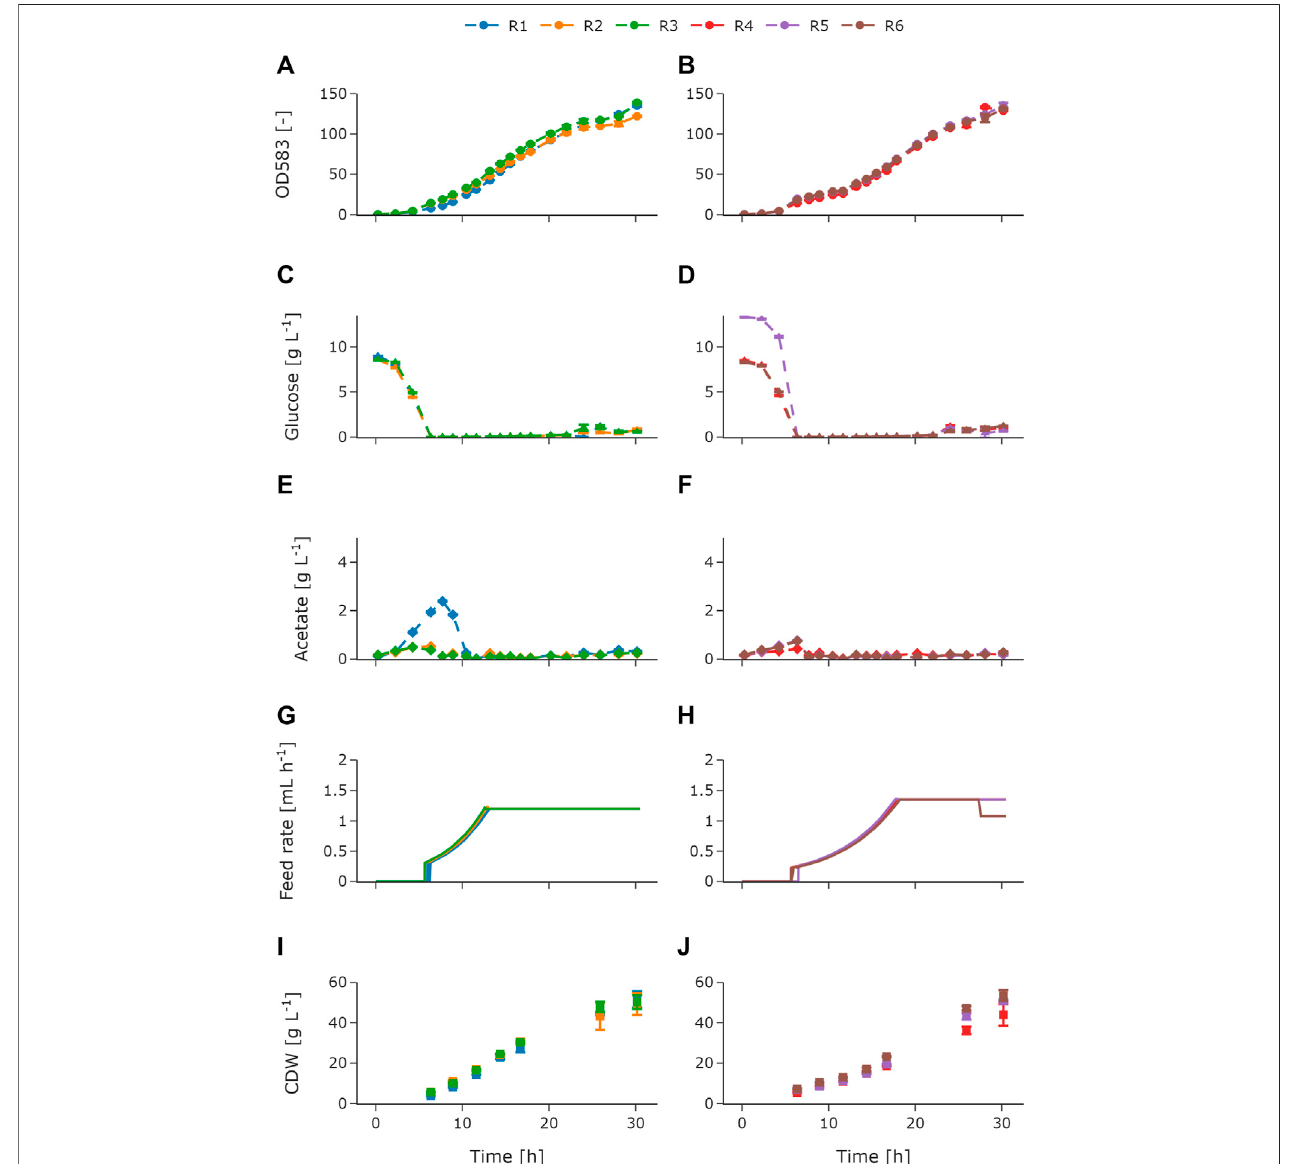
FIGURE 4 | Measured atline and of fl ine values of E. coli BW25113 fed-batch cultivations with two different feeding pro fi les as biological triplicates. OD 583 for R1 – R3 (A) and OD 583 for R4 – R6 (B) , glucose for R1 – R3 (C) and glucose for R4 – R6 (D) , acetate for R1 – R3 (E) and acetate for R4 – R6 (F) , feed rate for R1 – R3 (G) and feed rate for R4 – R6 (H) , and CDW for R1 – R3 (I) and CDW for R4 – R6 (J) . For R1 – R3, the exponential feed was set to μ set = 0.2 h − 1 for 6 h followed by a constant feed. For R4 – R6 the exponential feed was set to μ set = 0.15 h − 1 for 13 h followed by a constant feed. The initial offset in the glucose concentration for R5 was due to